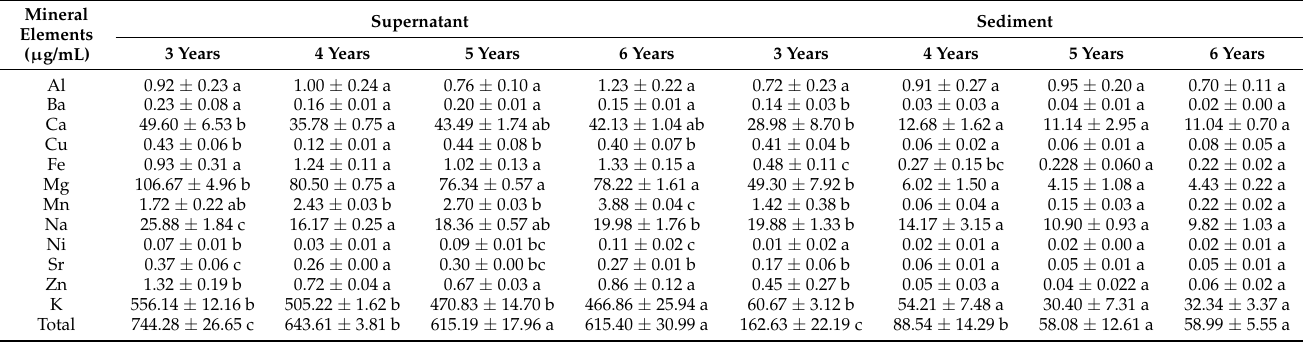
Table 2. Analysis of the mineral elements of the extract and sediment of ginseng of different ages.